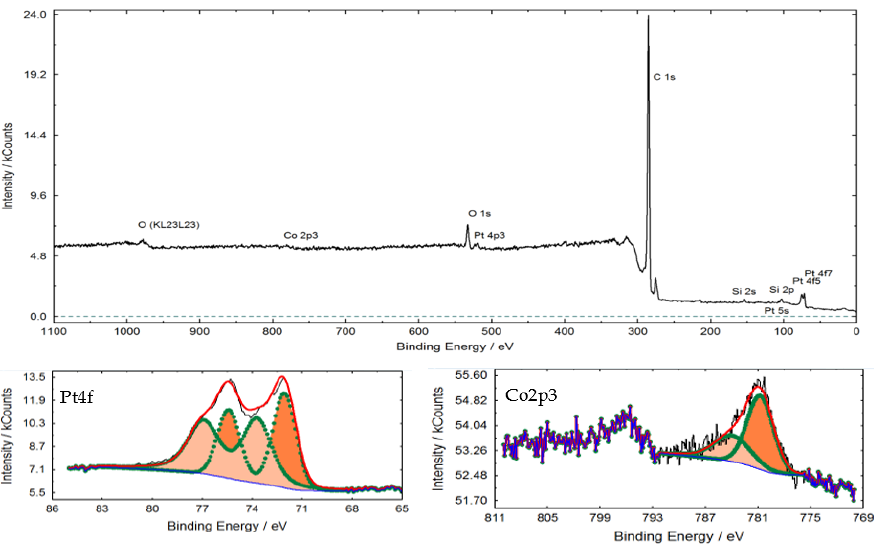
Figure 5. Overview XPS spectrum for PtCo/CNT catalyst and spectra for individual Co and Pt.